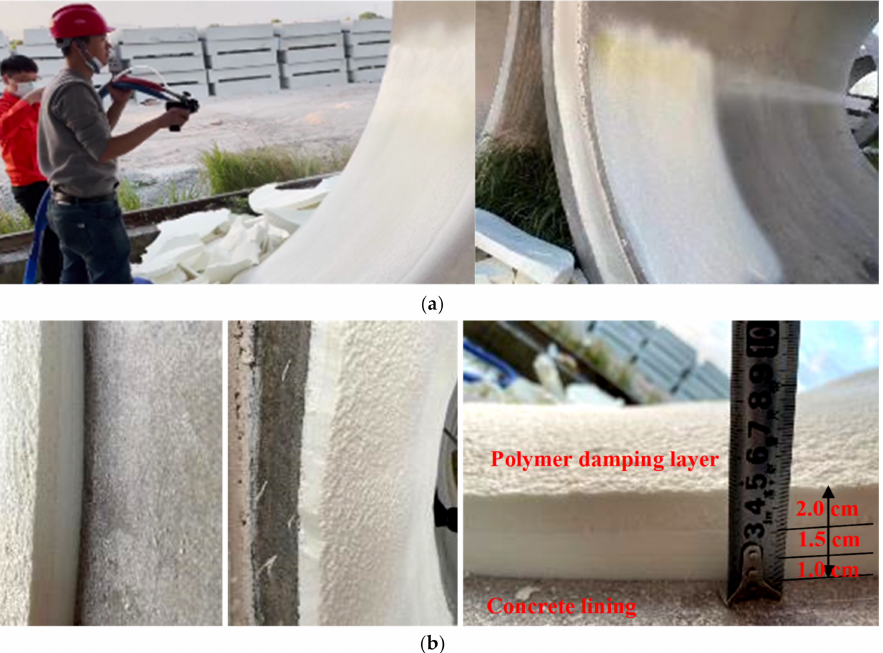
Figure 12. Spraying construction process of polymer damping layer and illustration of layered spraying effects: ( a ) spraying construction process; ( b ) spraying effects.